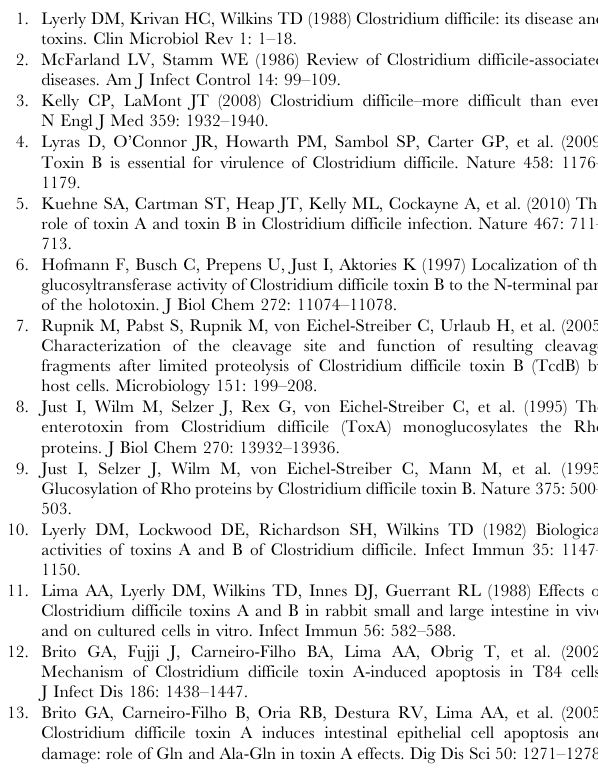
Figure S3 TcdB and TcdB autoprocessing mutants have the same cytotoxicity kinetics. A , TcdB, TcdB C698S, TcdB C698A, and TcdB L543A at 10 nM induce HeLa cell death at similar rates, as detected by Live/Dead Cell Imaging dyes. Values represent the number of red (dead) cells per total number of cells (red + green) over six image fields and were calculated using Columbus Analysis Software. Dead cells were defined as having a red intensity greater than 450 relative units. B , Representative pictures of TcdB treated cells at 0 and 120 minutes. Images were taken using an Opera High-Throughput Confocal Screening Microscope. Figure S4 TcdB and TcdB autoprocessing mutants have different cytopathic kinetics at 1 fM. HeLa cells were treated with multiple concentrations of wild-type and mutant TcdB proteins and imaged every 10 minutes over a 2 hour time course. The percentage of round cells was quantified over six fields for each concentration and time point. Percent rounded cells induced by TcdB and autoprocessing mutants is shown at concentrations of A , 10 nM, B , 1 nM, C , 100 pM, D , 10 pM, E , 1 pM, F , 100 fM, G , 10 fM, and H , 1 fM. Differences in the rounding kinetics between TcdB and autoprocessing mutants begin to appear at a concentration of 100 fM and are